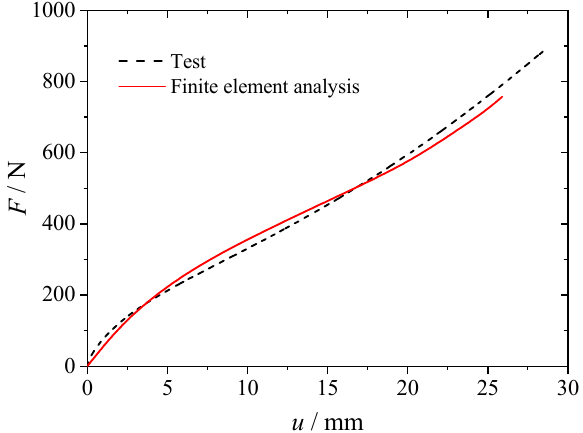
Figure 5. Tensile force-displacement curves of the hourglass specimen obtained from numerical analysis and lab tests.